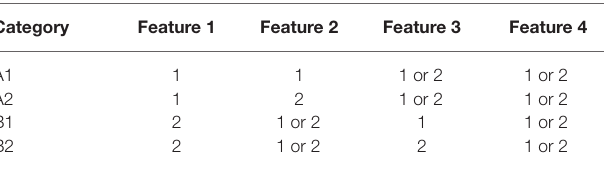
TABLE 2 | Alien categories with corresponding feature values for categorization.